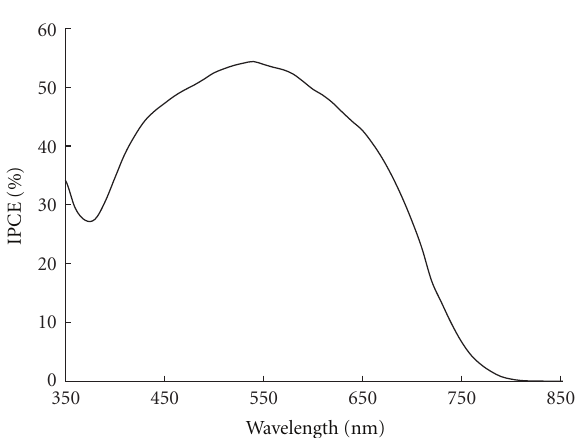
F 3: Photocurrent action spectra of the DSCs with MWNT- PAni/PMII composite electrolyte. e incident photon-to-current conversion efficiency is plotted as a function of wavelength. A sandwich-type sealed cell con�guration was used to measure this